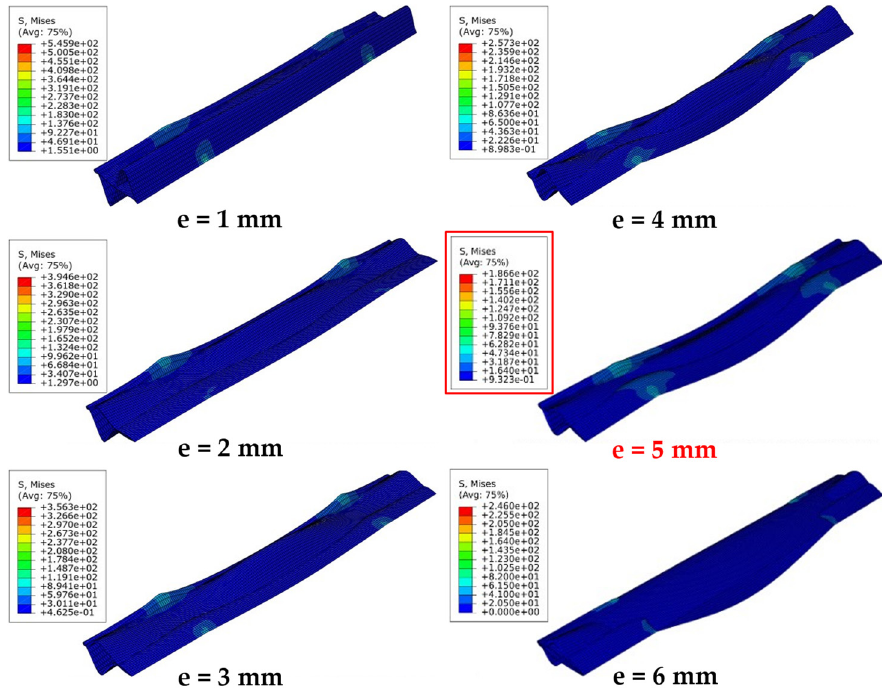
Figure 11. Plot of the quarter chord trajectory along the length of the VAWT blade span.